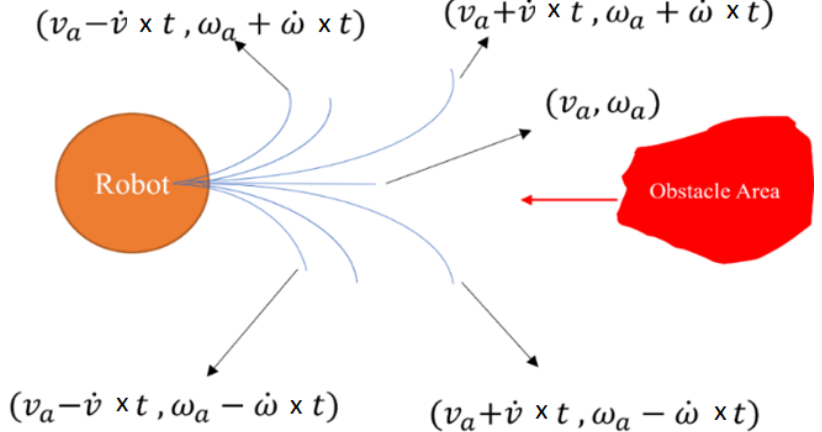
Figure 3. An illustration of possible collisions based on sampling in velocity space.